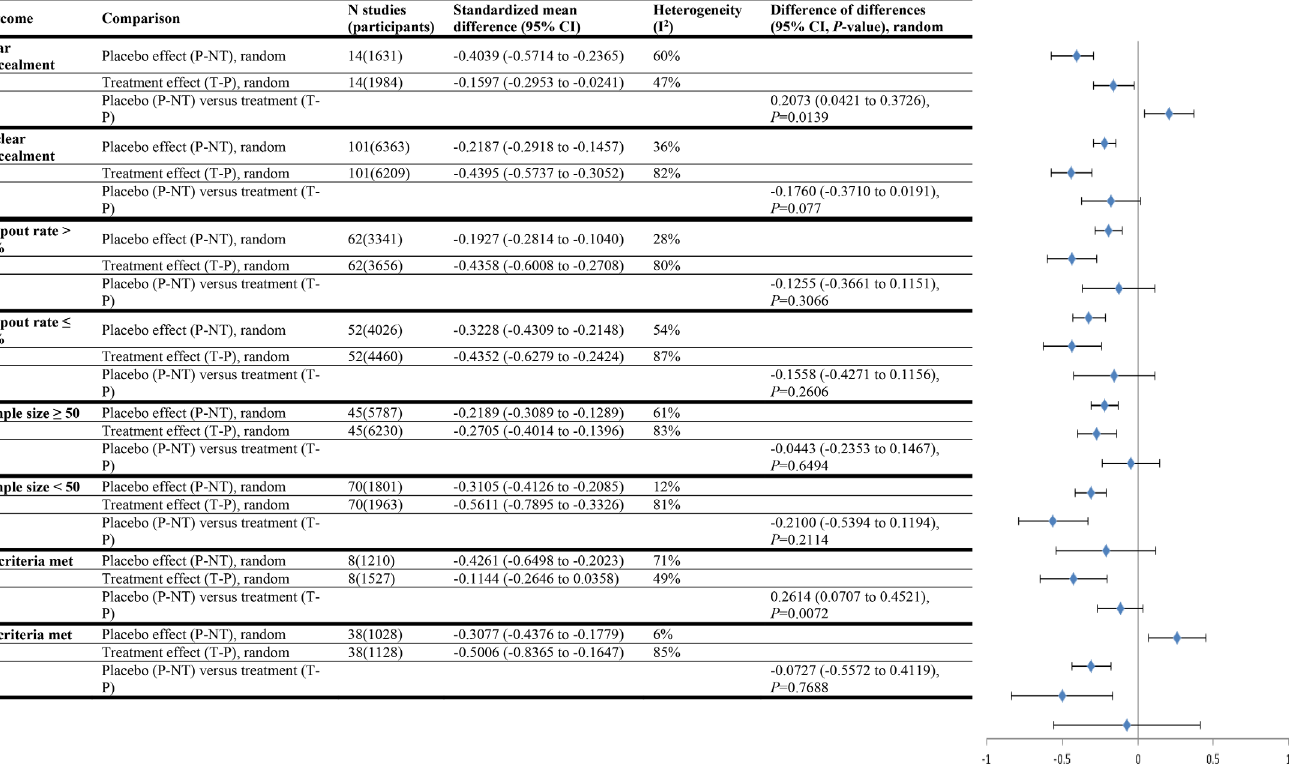
Fig 5. Trials with varying degrees of bias (continuous